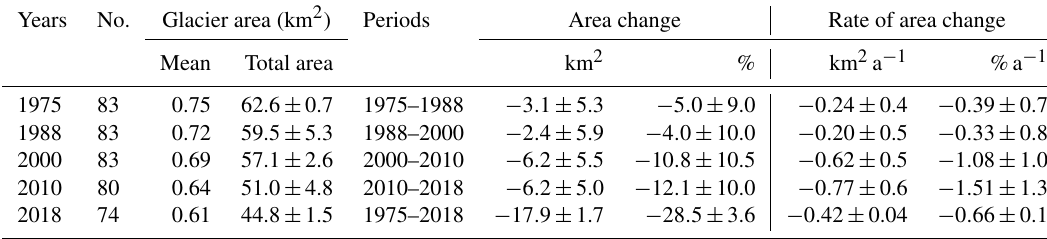
Table 4. Glacier area dynamics in the total area of the Chhombo Chhu Watershed, the Sikkim Himalaya (1975–2018).